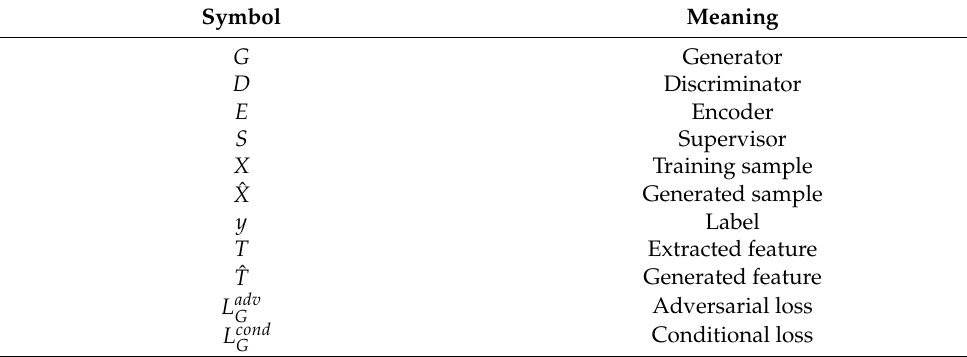
Table 1. Instruction for the symbols in Figure